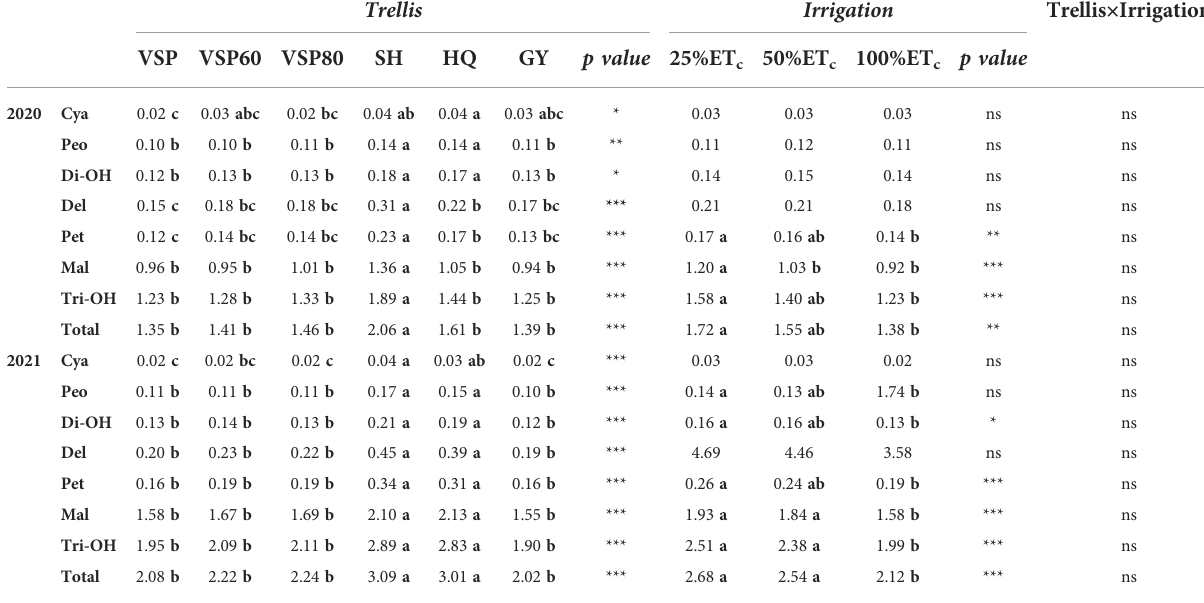
TABLE 3 Effects of trellis systems and applied water amounts on berry skin anthocyanins of ‘ cabernet sauvignon ’ in Oakville, CA, USA in 2020 and 2021 a, b, c . Trellis Irrigation